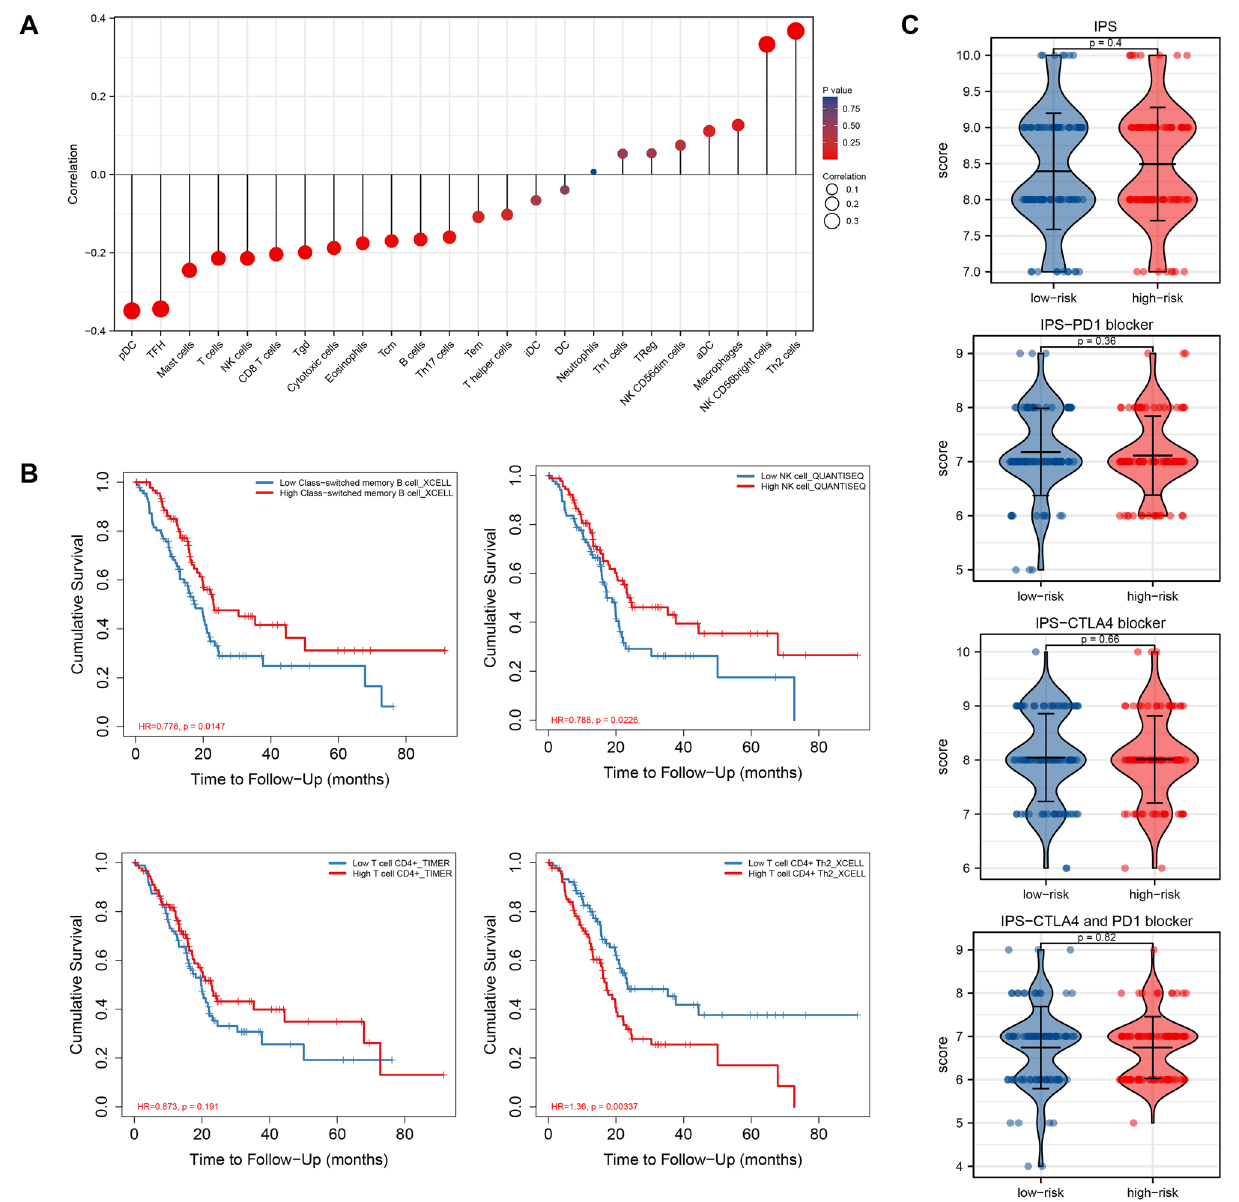
Figure 11. Analysis of correlation between PAAD-IRGS and immune-related cells and relevant immunotherapy. ( A ) Lollipop plot of PAAD-IRGS and immune infiltration cells correlation in TCGA-PAAD; ( B ) survival analysis of immune-related cells infiltration in PAAD; ( C ) analysis of immunotherapeutic efficiency based on PAAD-IRGS in TCGA-PAAD. IPS immunephenoscore. * P < 0.05, ** P < 0.01, *** P <